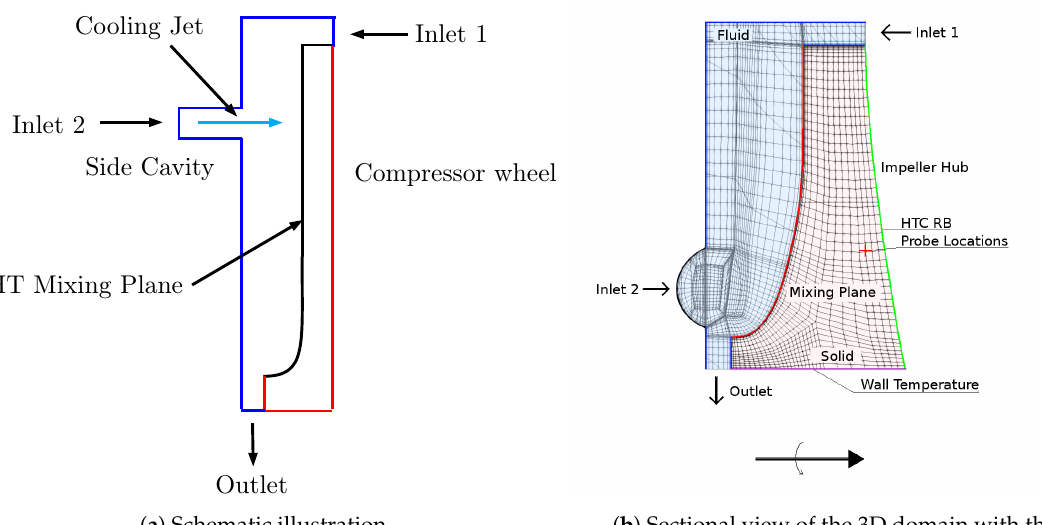
Figure 7. Boundary conditions and